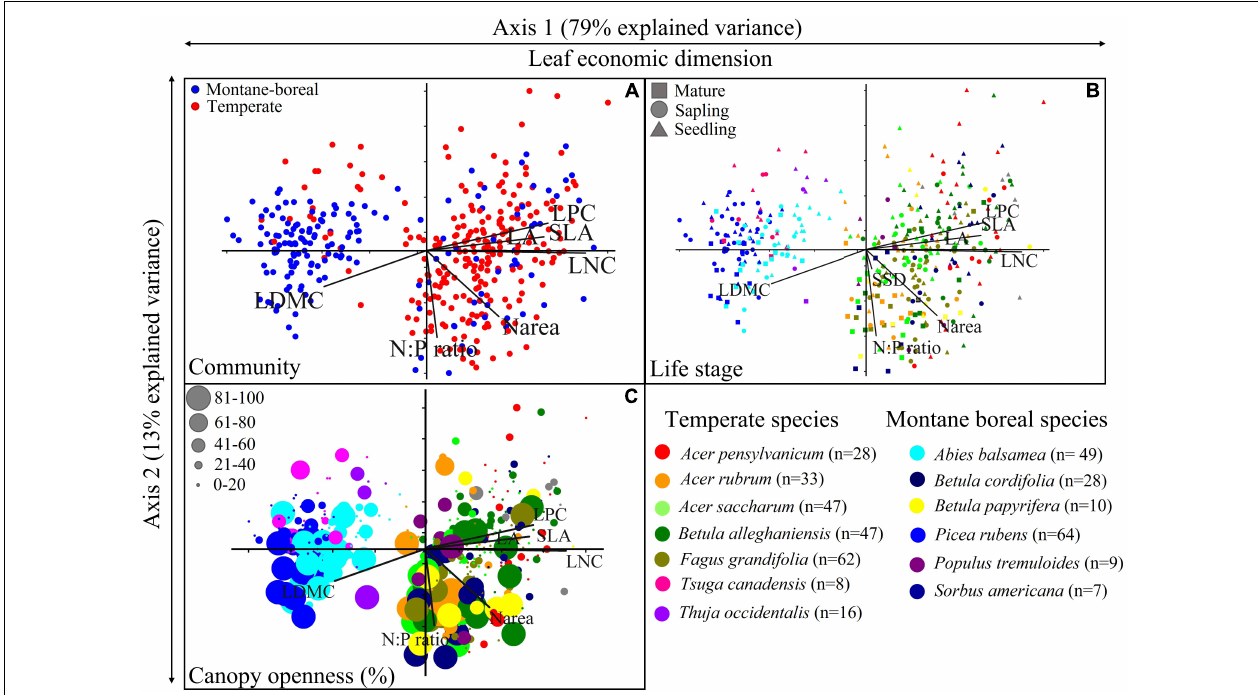
FIGURE 2 | Ordination of functional traits in relation to different taxonomic and structural groupings. (A) Ordination of individual trees by community type with functional traits overlaid. (B) Canopy openness for individual trees is highlighted using circle size, with species identified by color. (C) Life stage of individual trees is highlighted using circle size, with species identified by color. Sample size within the ordination is shown in the legend next the scientific name of the species. Trait acronyms; Specific leaf area (SLA), leaf area (LA), leaf dry matter content (LDMC), leaf nitrogen concentration (LNC), leaf phosphorous concentration (LPC), leaf nitrogen per unit area (Narea), stem specific density (SSD), leaf nitrogen to phosphorus ratio (N:P).